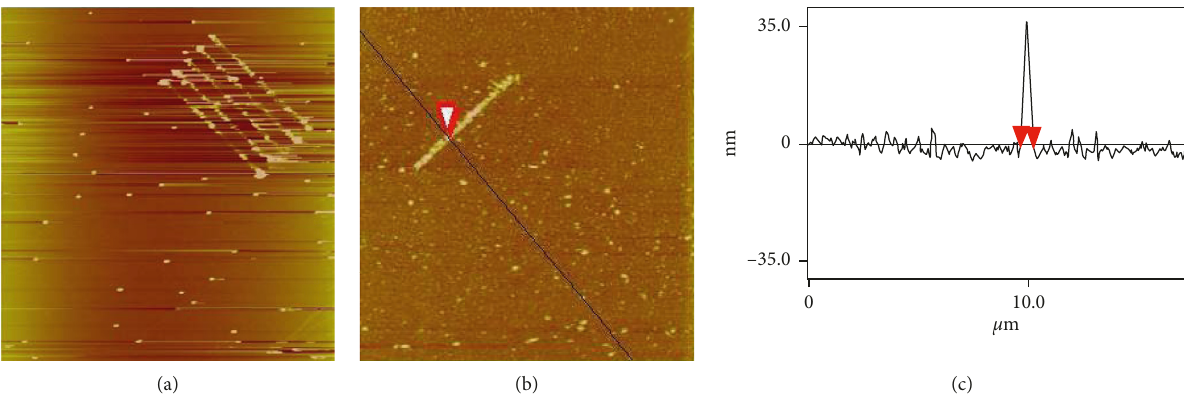
Figure 5: (a, b) 30 30 μ m 2 atomic force microscopy topographic images of NeutrAvidin-functionalized polystyrene nanoparticles attached × to the shaved part of the monolayer. (c) Section analysis of